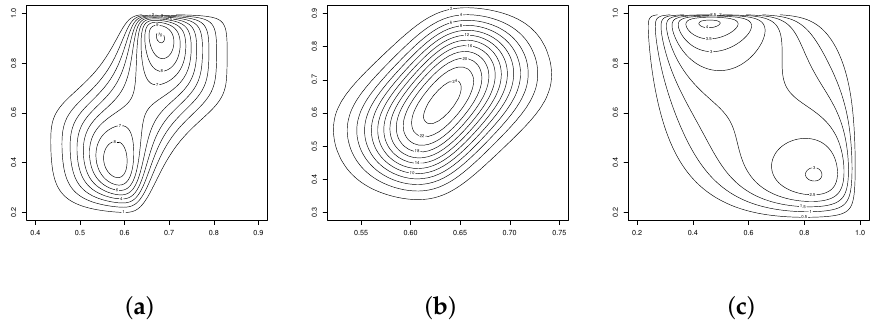
Figure 1. Graphs of contours for the BVSUSHN distribution for: ( a ) BVSUSHN ( 0.5,1.5,0,0,1,1,1.5 ) , ( b ) BVSUSHN ( 0.25,0.75,0,0,1,1,0.75 ) , and ( c ) BVSUSHN ( 1.25,1.75,0,0,1,1, − 0.75 )